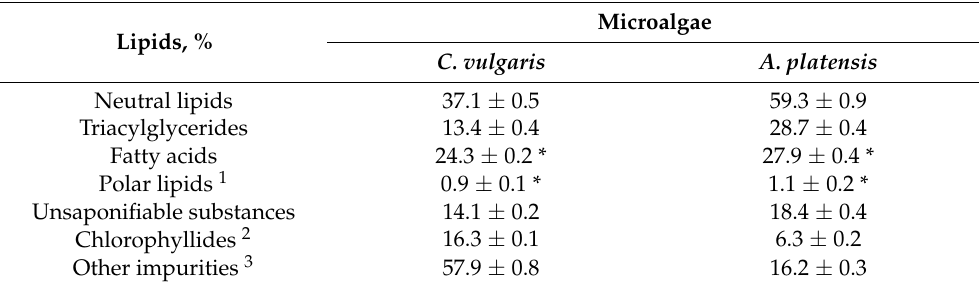
Table 2. Qualitative and quantitative content of the lipid fraction of the lipid complex of microalgae